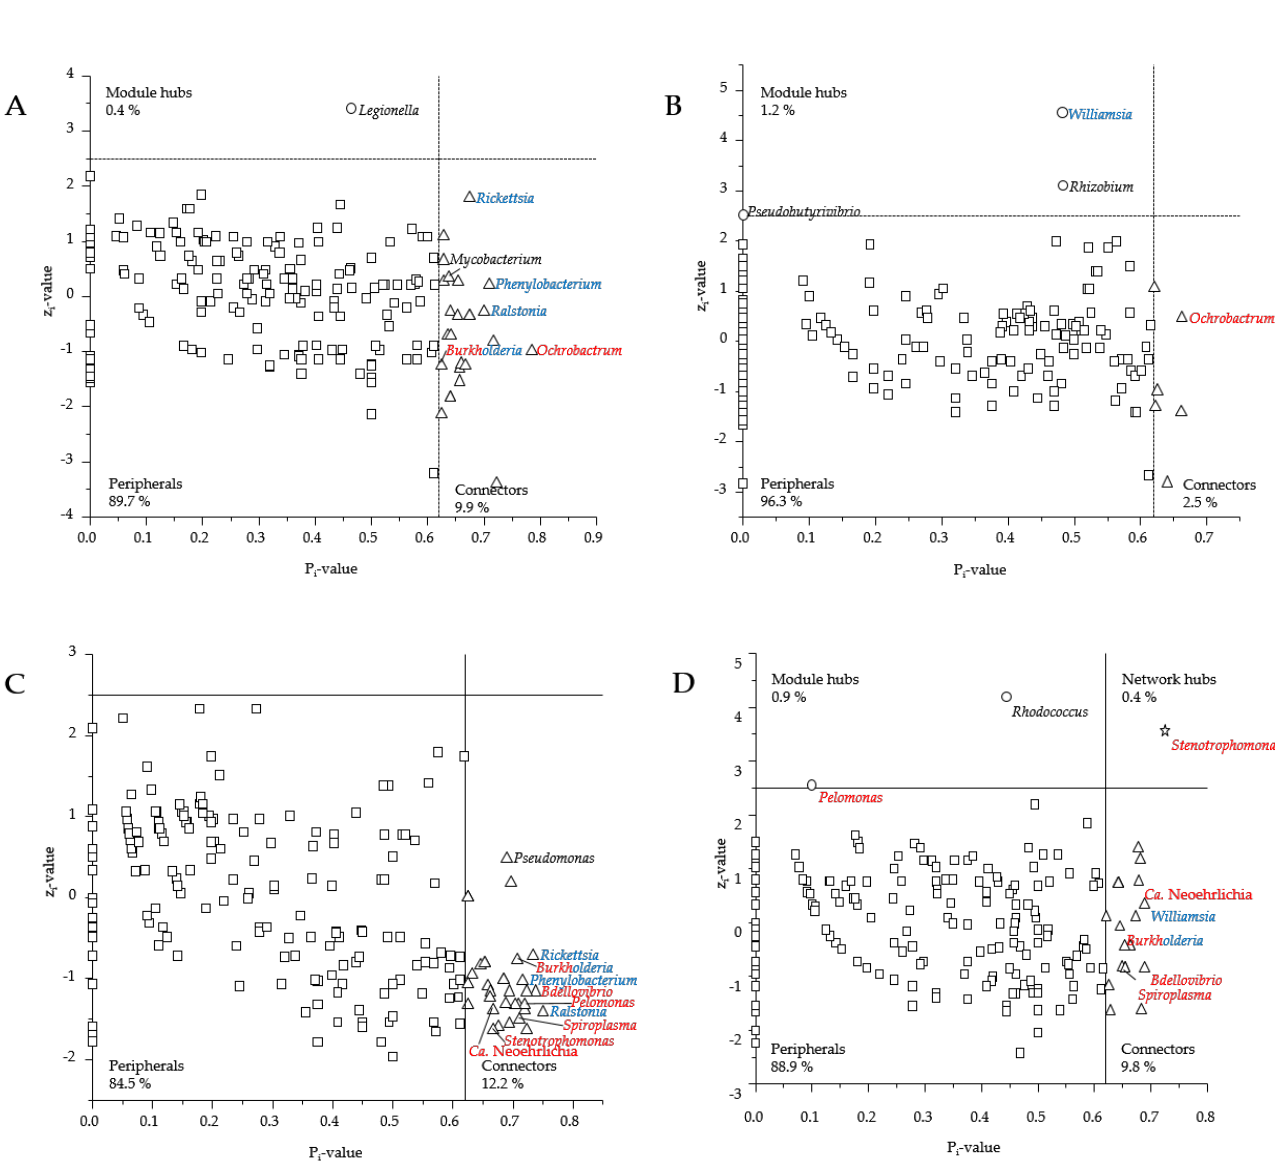
Figure 4. Topological roles of each node (bacterial genus) of a microbial network analyses for EN (( A ); n = 62), EP (( B ); n = 38), WN (( C ); n = 56) and WP (( D ); n = 44) according to their zi and Pi values. All nodes of the networks were categorized into one of four groups (peripherals, connectors, network and module hubs) according to their z i and P i values, as Olesen et al. suggested [48]. Module hubs are marked as a circle, network hubs as a star, peripherals as square, and connectors as a triangle. The blue labeled genera occurred in the other network of the same locus (EN and EP or WN and WP) with the same or changed topological role (blue), while the red labeled genera occurred in the network of the other locus (EN and WN or EP and WP) with the same or changed topological role. An overview of the co-occurrence patterns of all nodes can be found in the appendix (Supplementary Table S2).